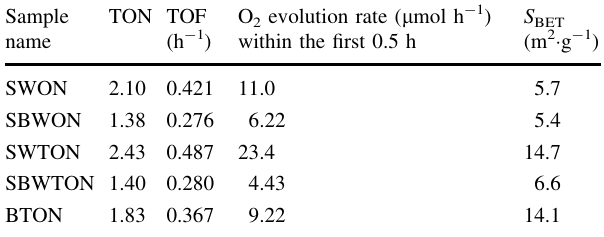
Table 3 Photocatalytic performance of CoO x -loaded Sr 1 - x Ba x -